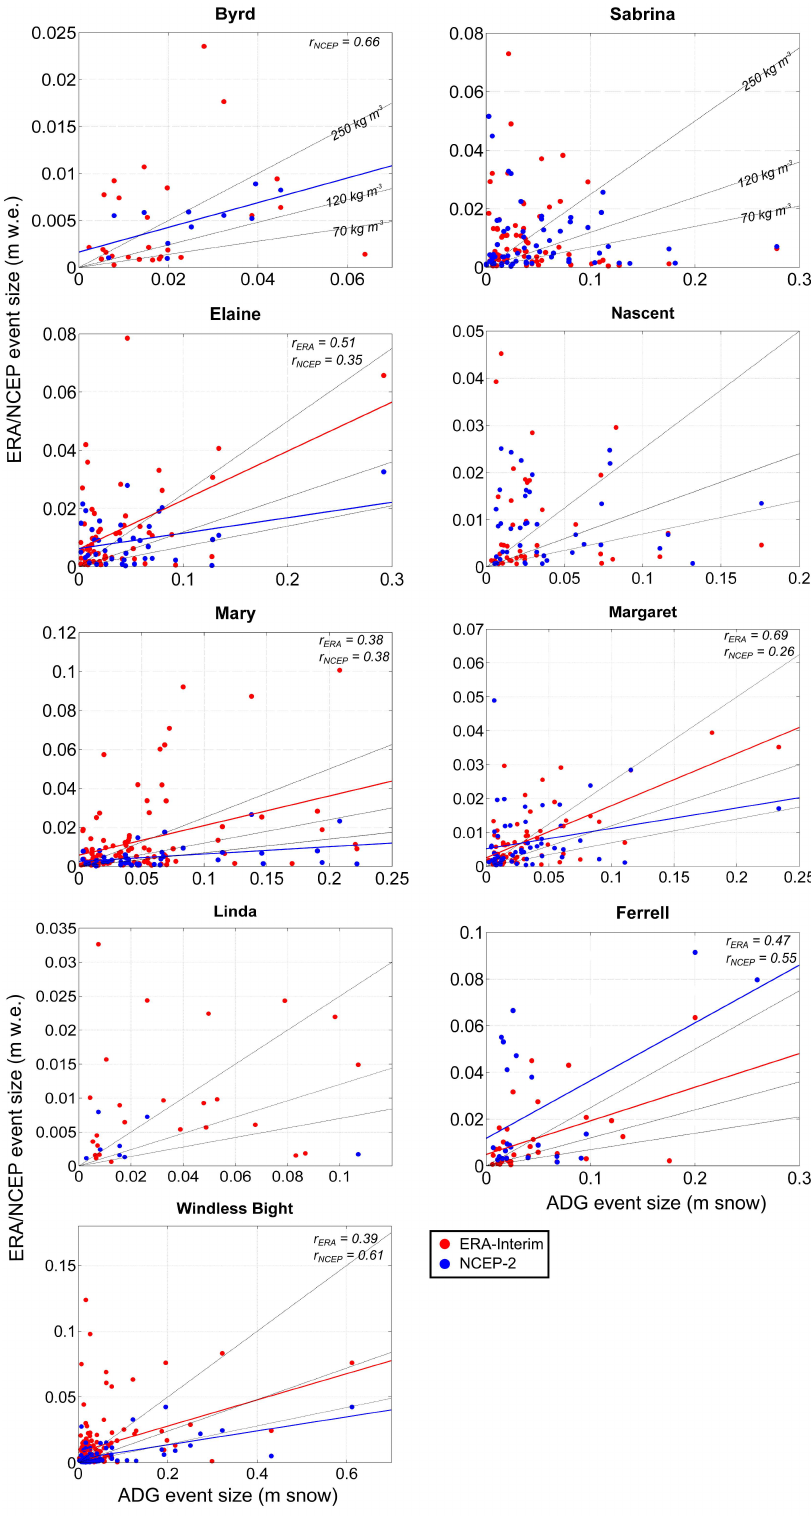
Fig. 5. Comparison of event sizes for all coincident events. ADG event sizes are m snow; reanalyses event sizes are mw.e. Regression lines and r values are shown for correlations at 90% significance level. Black lines indicate the slope of the regression that would be expected for snow densities at various ranges (freshly fallen snow, ρ = 70–120kgm − 3 ; wind-redistributed snow, ρ = 250kgm − 3 )